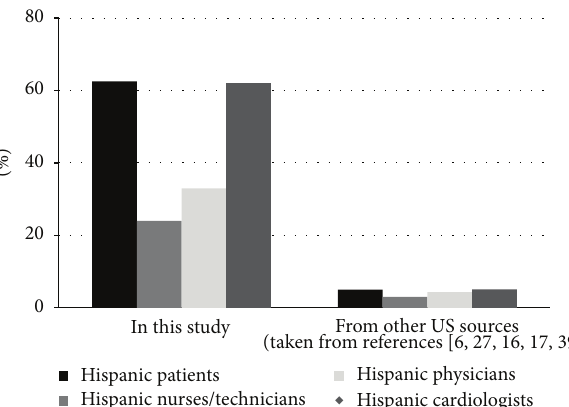
Figure 1: Proportion of Hispanic patients, nurses/technicians and physicians from the hospital in this study and from the database published from other US facilities and